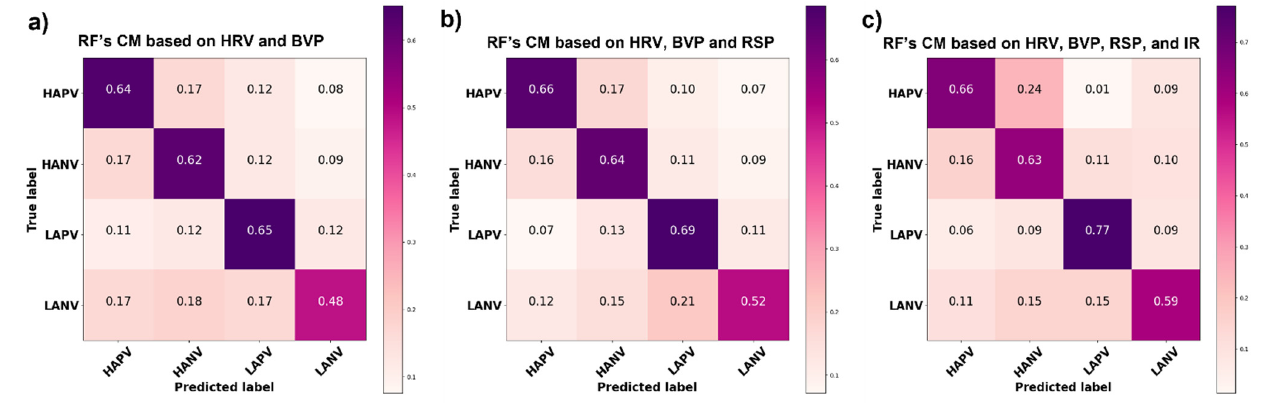
Figure 5. Normalized confusion matrix of ( a ) Random Forest emotion classification based on cardiac features, ( b ) Random Forest emotion classification based on cardiac and respiratory features, and ( c ) Random Forest classification outcome relied on cardiac, respiratory, and thermal features.